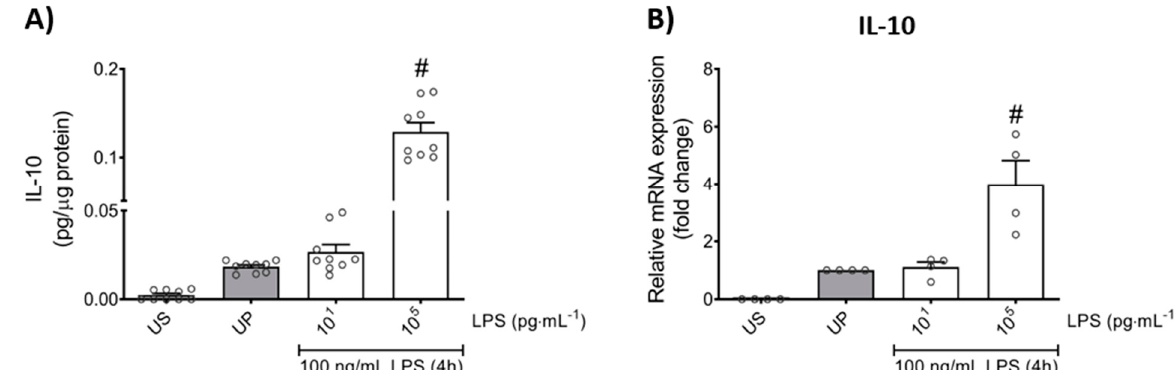
Figure 3. Effects of low- and high-dose LPS priming on the production of IL-10 as anti-inflammatory cytokine in mouse bone marrow neutrophils. Cells were primed with different doses of LPS (low-dose: 10 pg/mL; high-dose: 100 ng/mL) and re-challenged on day 2 with a fixed dose LPS (100 ng/mL) as described. Supernatants and RNA samples were collected 4 h after the second challenge. Production of ( A ) IL-10 (n = 9) was measured using ELISA (normalized to total protein concentration), whereas ( B ) gene expression of IL-10 (n = 4) by real-time PCR normalized to glyceraldehyde-3-phosphate dehydrogenase (GAPDH) representing relative values to unprimed state (assigned as 1.0). Data are shown as scatter dot plots, mean + SEM, # p < 0.05, #significant differences vs. unprimed condition (UP, gray column).